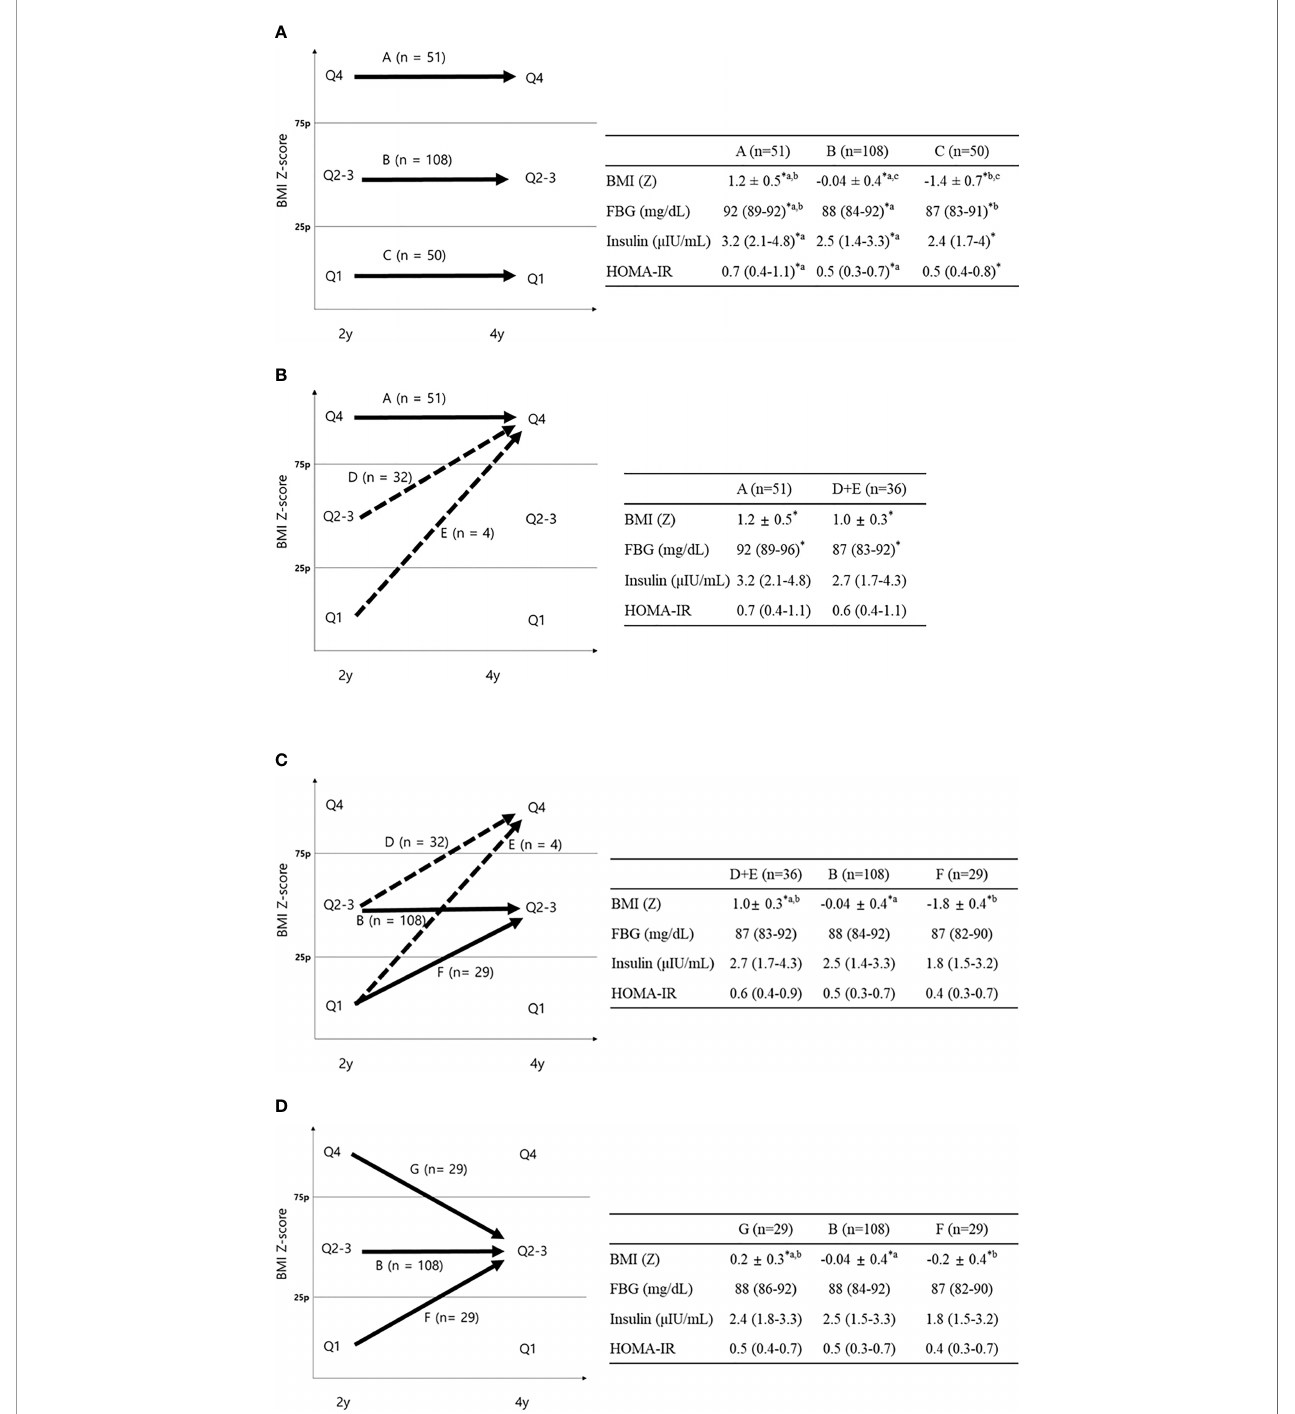
FIGURE 2 | FBG, insulin, and HOMA-IR according to BMI Z-score quartile change. Data are shown as the mean ± standard deviation or median (interquartile range). * P < 0.05 between groups. (A) Comparison between groups A – C ; a P < 0.05 between groups A and B ; b P < 0.05 between groups A and C ; c P < 0.05 between groups B and C using Bonferroni post-hoc analysis. (B) Comparison between groups A and D+E (dotted line). (C) Comparison between groups D+E , B , and F (D) Comparison between groups B , F , and G a p < 0.05 between groups B and G ; b P < 0.05 between groups B and F using Bonferroni post-hoc